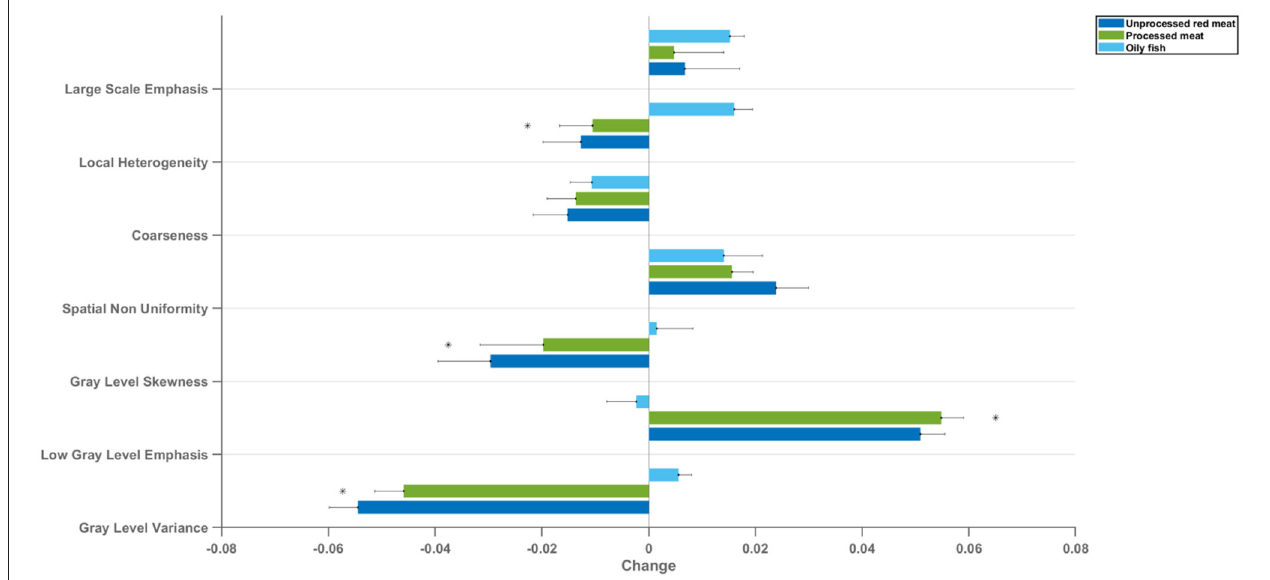
FIGURE 5 | Mean change in LV myocardium CMR radiomics texture feature clusters per 100g increase in daily meat consumption. Each bar represents mean standardised beta coefficients corresponding to the indicated texture feature cluster. Models are adjusted for age, sex, social deprivation, educational level, smoking, alcohol intake, and exercise level (confounder adjusted model). Black lines represent half-length of confidence interval for the corresponding bar. CMR: cardiovascular magnetic resonance; LV: left ventricle *denotes p < 0.05 in using Kruskal–Wallis statistical testing followed by Dunn’s correction test for multiple comparisons between oily fish and unprocessed red meat and between oily fish and processed red meat.